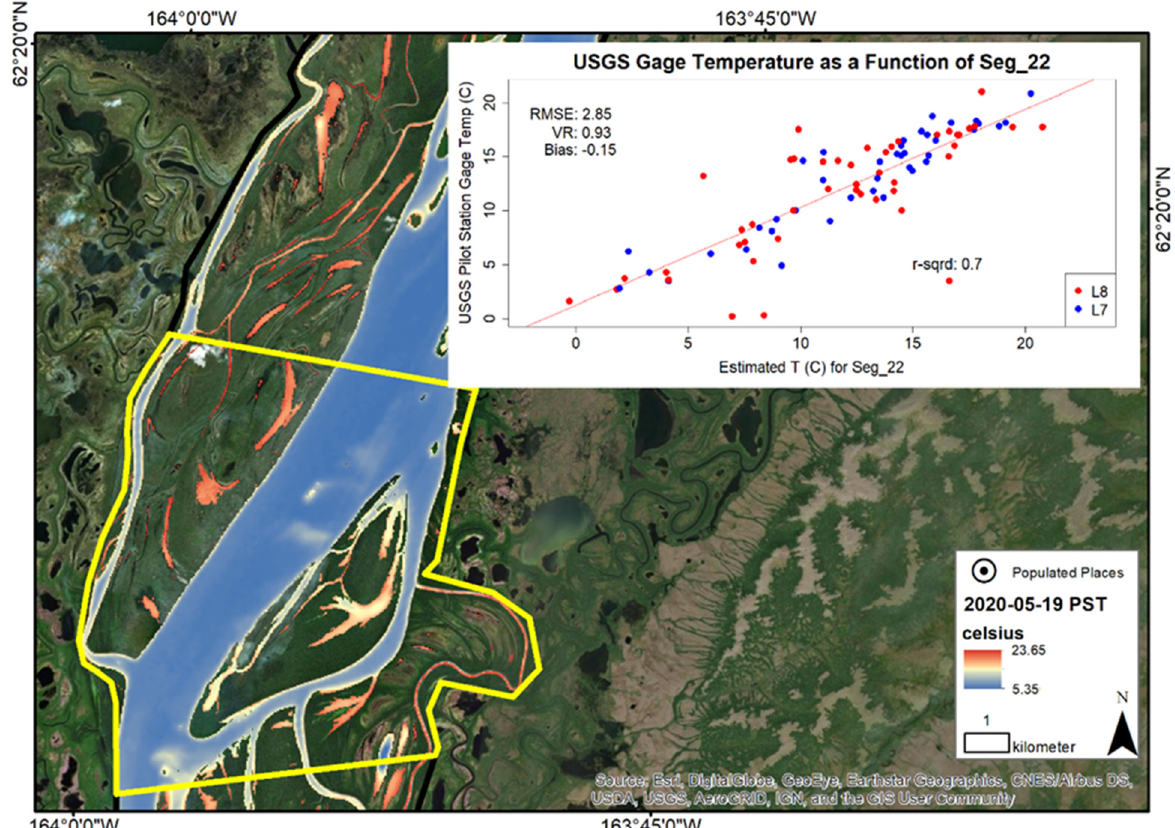
Figure A20. Segment 22 captures sloughs rejoining the Yukon River on the east bank as well as the large Tunurokpak Channel leaving the western bank. This channel maintains water temperatures similar to those in the main stem. Another unnamed channel flows around a large forested island, which at high river stages also contains warm backwater features. In the scene above, slightly warmer water in the main channel reveal where sand and gravel bars emerge during intermediate and low flow stages. Both shores of the river are made up of lowland flood plains featuring lakes and abandoned channels. The pST is 100% with no NoData gaps. Correlation between pST estimates and Pilot Station recorded data is r 2 = 0.704 which is slightly less than the upper levels of correlation seen elsewhere along the river. Agreement remained good with RMSE = 2.85 °C. This is the third highest RMSE from all river segments.